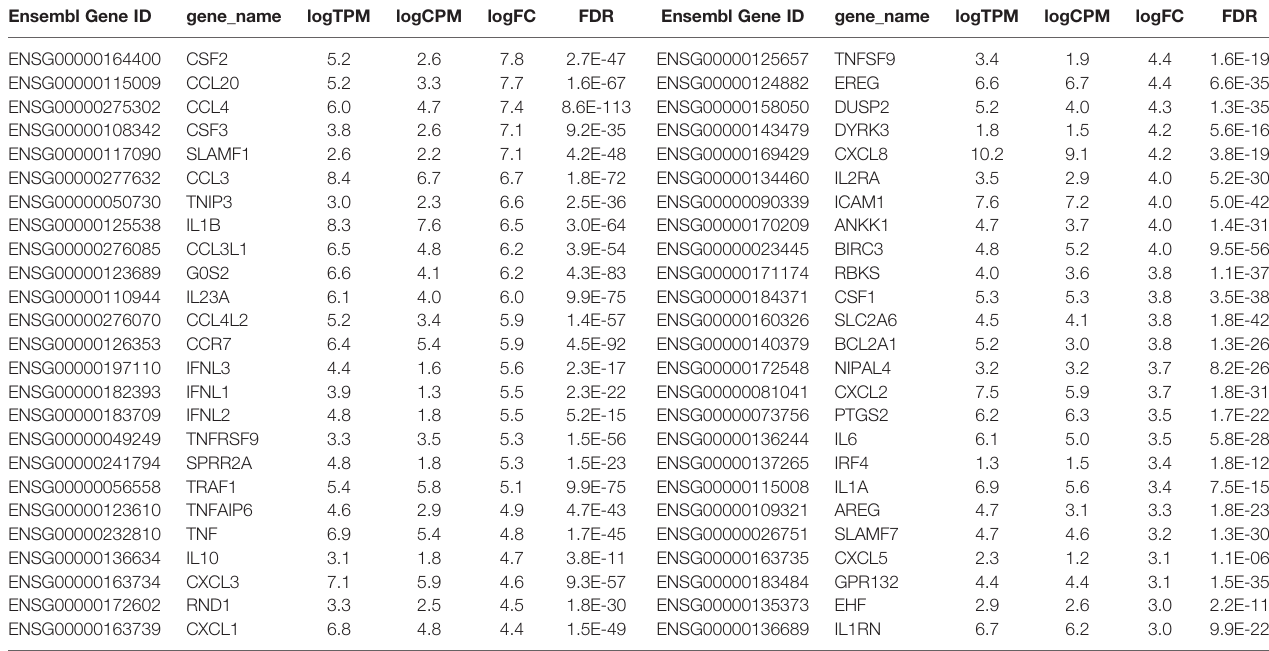
The top 50 upregulated PHT DEG are represented based on log 2 (FC) and FDR. Data are the average of three independent experiments. TPM, transcripts per million; CPM, counts per million; FDR, false discovery